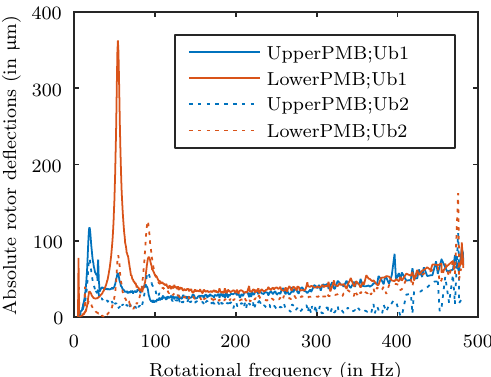
Figure 11. Measured deflections of the system according to applied unbalances as given in Table 4.